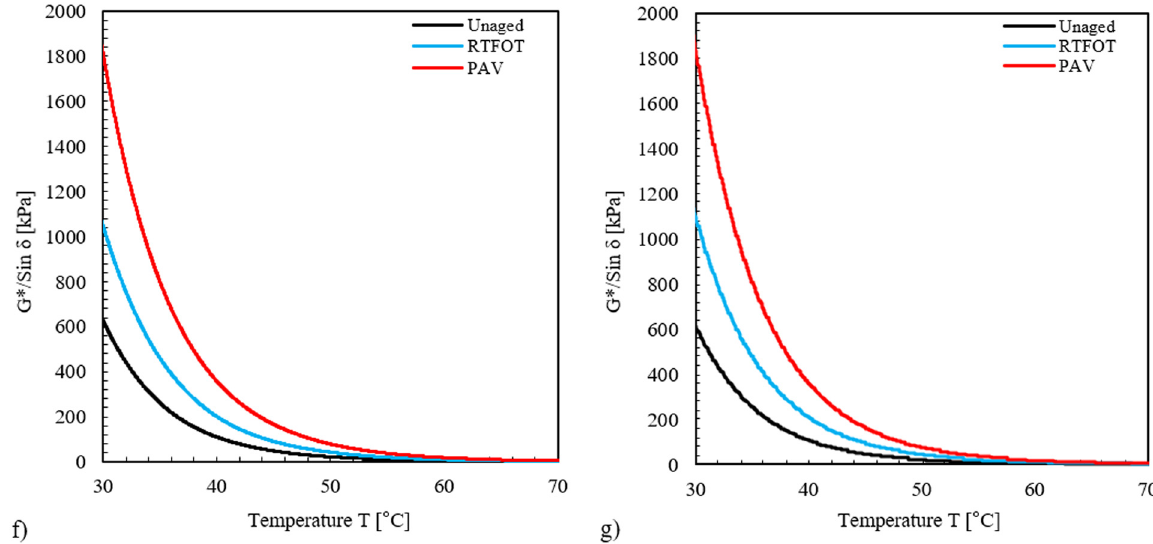
Figure 4: Phase angle and complex modulus of modi fi ed asphalt binder, ( a ) 0.1 wt%, ( b ) 2 wt%, and ( c ) 3 wt% CSNPs. Rutting resistance of CSNP - modi fi ed binder in short - and long - term aged and unaged conditions for ( d ) base samples, ( e ) 0.1 wt% CSNPs, ( f ) 0.2 wt% CSNPs, and ( g ) 0.3 wt% CSNPs.